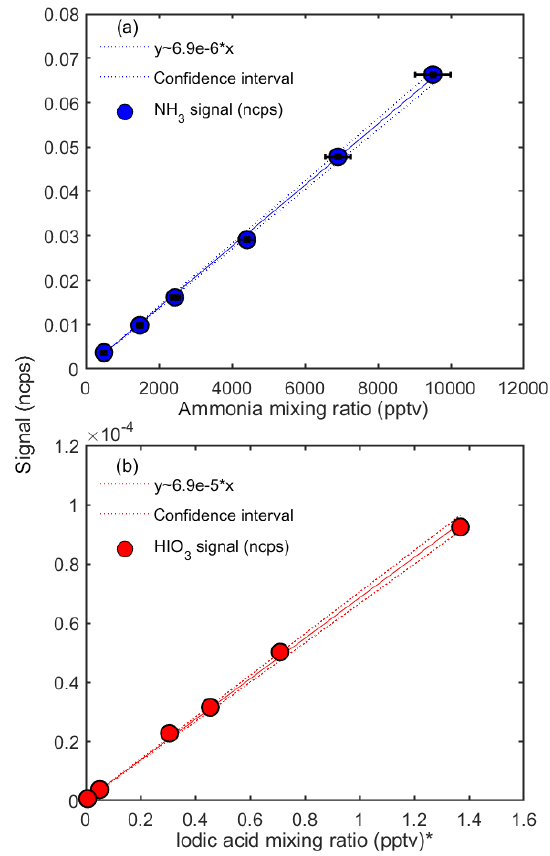
Figure 3. Calibration curves for ammonia (a) and iodic acid (b) at 40% relative humidity. The y axes show the normalized counts per second (ncps) measured with the water cluster CI-APi-TOF. The ammonia mixing ratios are determined from the calibration setup, and the iodic acid mixing ratios are taken from simultaneous mea- surements with a nitrate CI-APi-TOF at the CLOUD chamber. The systematic uncertainty of the iodic acid mixing ratios is estimated as + 100% / − 50% (Sipilä et al., 2016). The inverse slopes from the linear fits yield the calibration factors (see Eqs. 1 and 2). ∗ Note that the iodic acid mixing ratio is derived by applying a calibration factor for sulfuric acid to the nitrate CI-APi-TOF